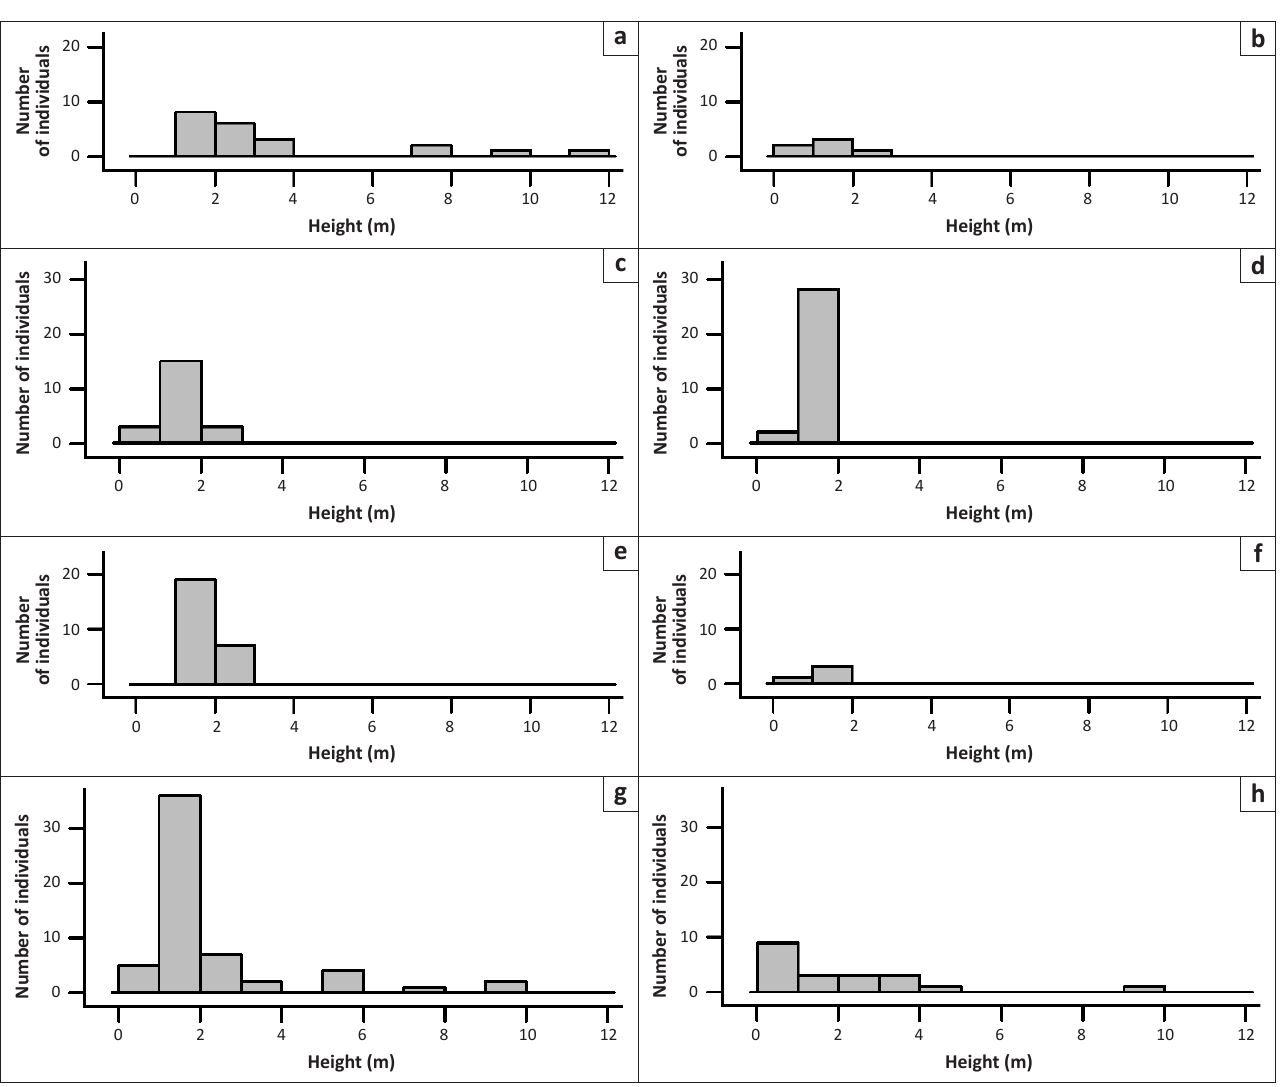
FIGURE 3: Size class distributions of Terminalia sericea populations growing (a) inside and (b) outside and Dichrostachys cinerea populations growing (c) inside and (d) outside of the Nhlangwini exclosure in the Kruger National Park.